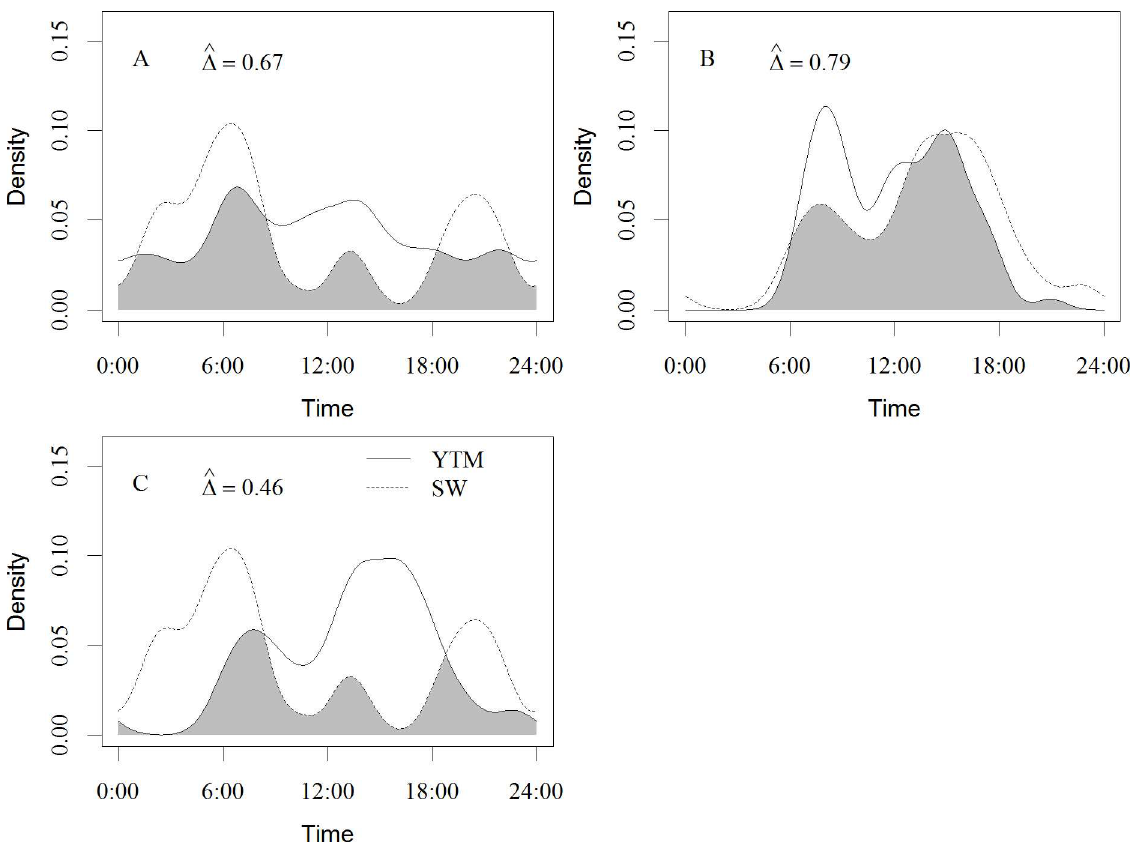
Fig 5. Diel activity patterns and overlap of yellow-throated marten (YTM) and Siberian weasel (SW) in the winter (Decemberto February) and between seasons in Southwest China. The overlaparea was denoted in grey. (A) overlap for Siberianweasel between seasons; (B) overlap for yellow-throated marten between seasons; (C) overlap between Siberianweasel and yellow-throated marten in